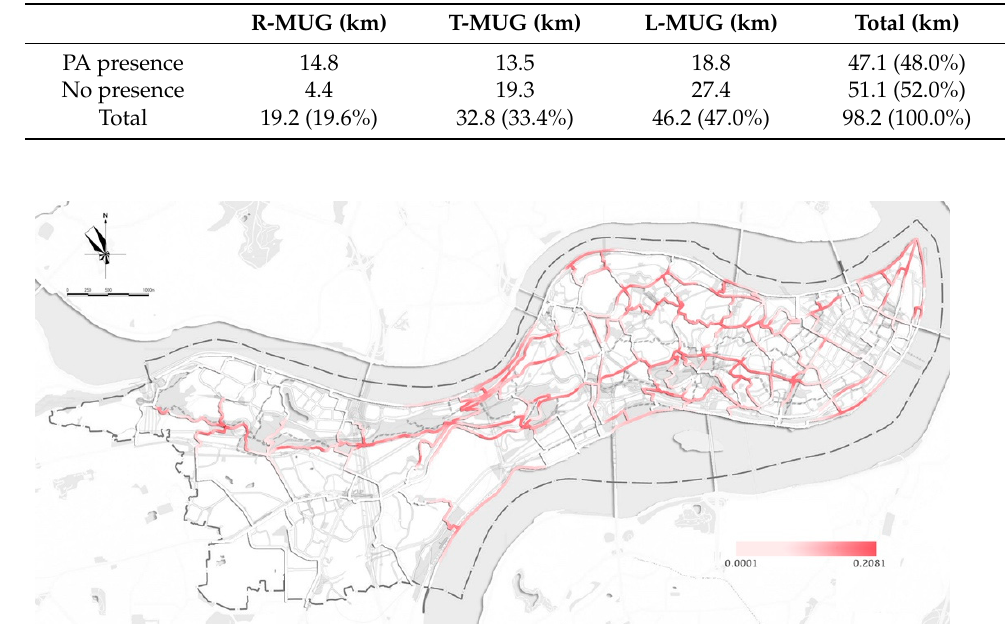
Figure 3. The PA density in the MUG of the Yuzhong Peninsula.